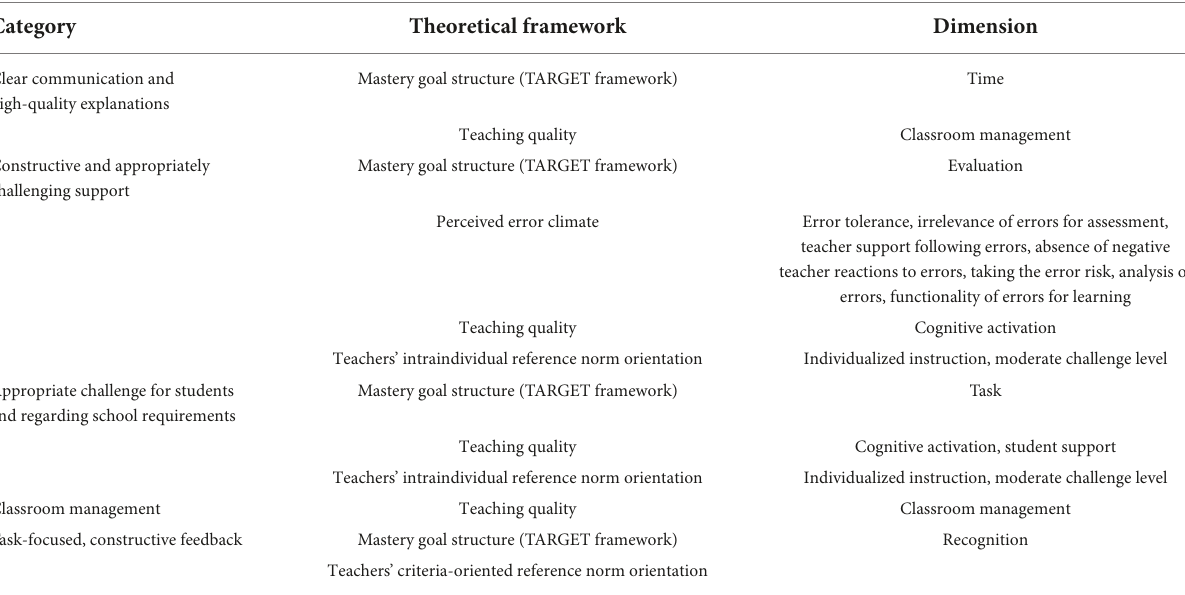
TABLE 2 Dimensions describing the factors that contribute to students’ competence satisfaction from a structure